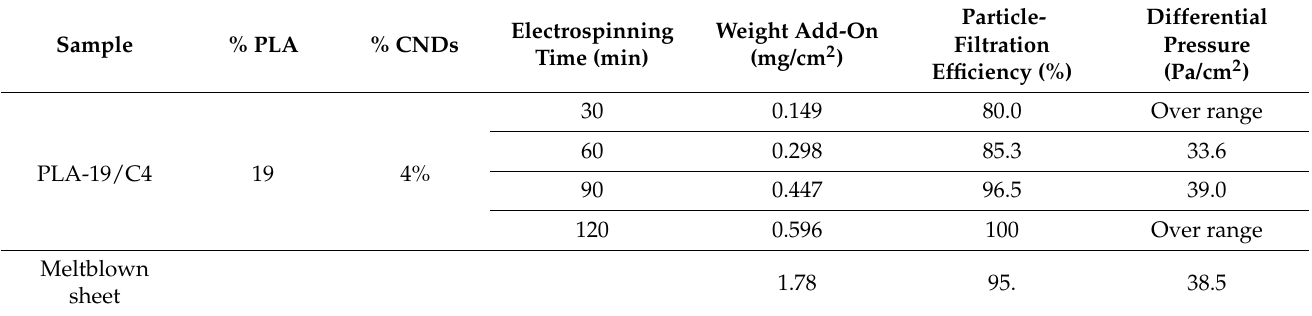
Table 2. Particle-filtration efficiency and differential pressure of PLA-19/C4 fibers on nonwoven sheet. Table 2. Particle- filtration efficiency and differential pressure of PLA - 19/C4 fibers on nonwoven sheet.